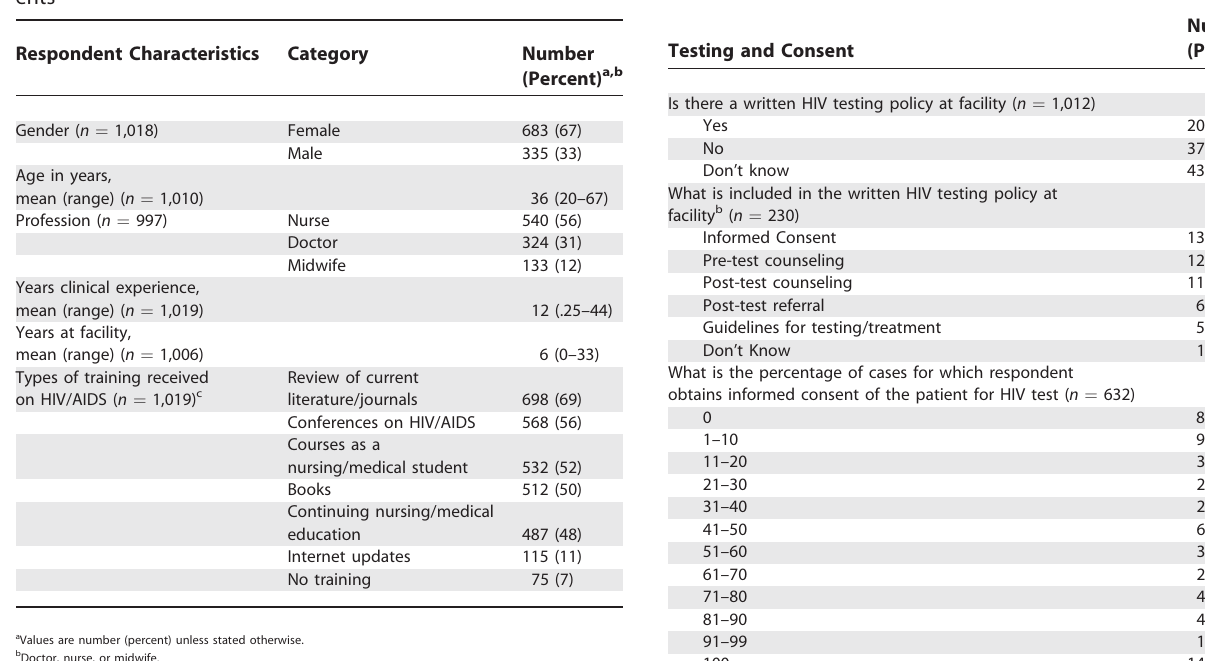
Table 3. HIV/AIDS Testing, and Consent,